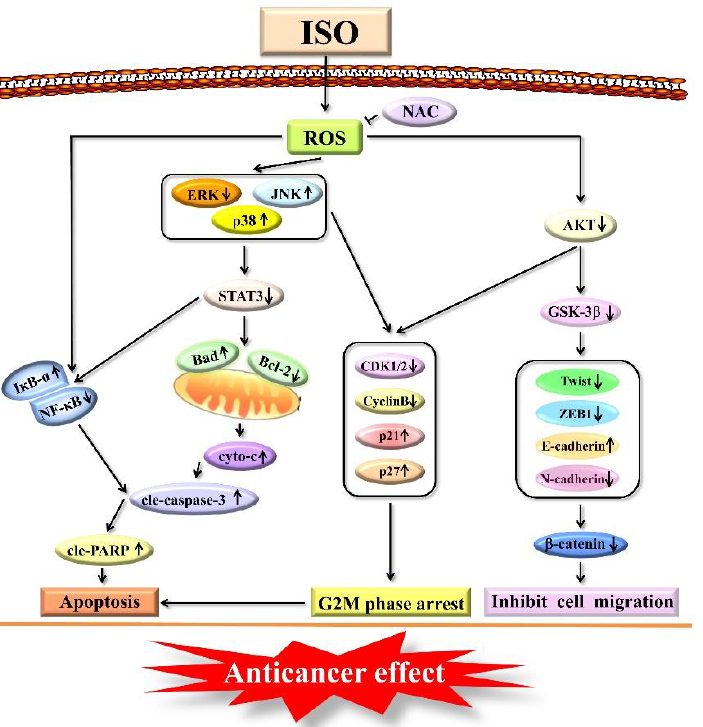
Figure 7. Schematic diagram of the signaling pathway of ISO in AGS cells to exert anti-cancer effects.